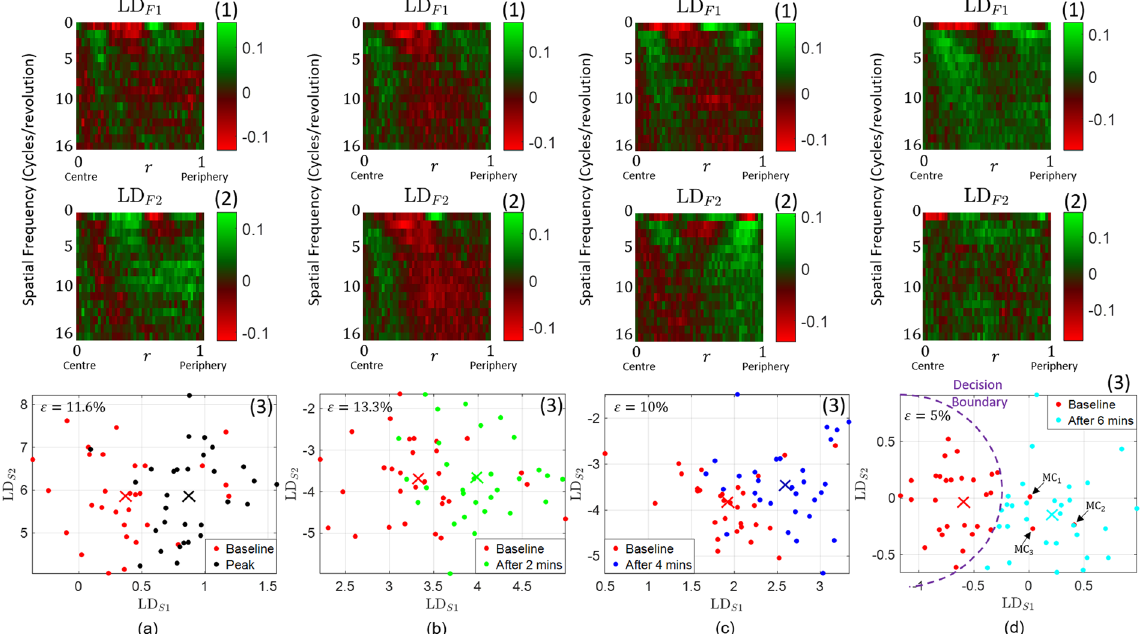
Figure 2. The discrimination outcome of the optimised machine learning algorithm to discriminate the logarithmic power spectrum of two blood conditions: ( a ) baseline against peak, ( b ) baseline against after 2 mins, ( c ) baseline against after 4 mins and ( d ) baseline against after 6 mins. The lowest error rate has been obtained when discriminating baseline and after 6 mins with e = 5% shown in the scatter plot (d,3) that illustrates the relationship between the first two LDA scores, i.e., LD s 1 and LD s 2 . Here MC i , where i = 1, 2, 3, refers to the misclassified baseline points. Figures (d,1) and (d,2) represent the first and second LDA functions, respectively, where each element of each row (frequency) corresponds to the average pixel intensity at a given radius. The spatial frequency of the linear discriminant functions is measured in units of cycles per revolution.